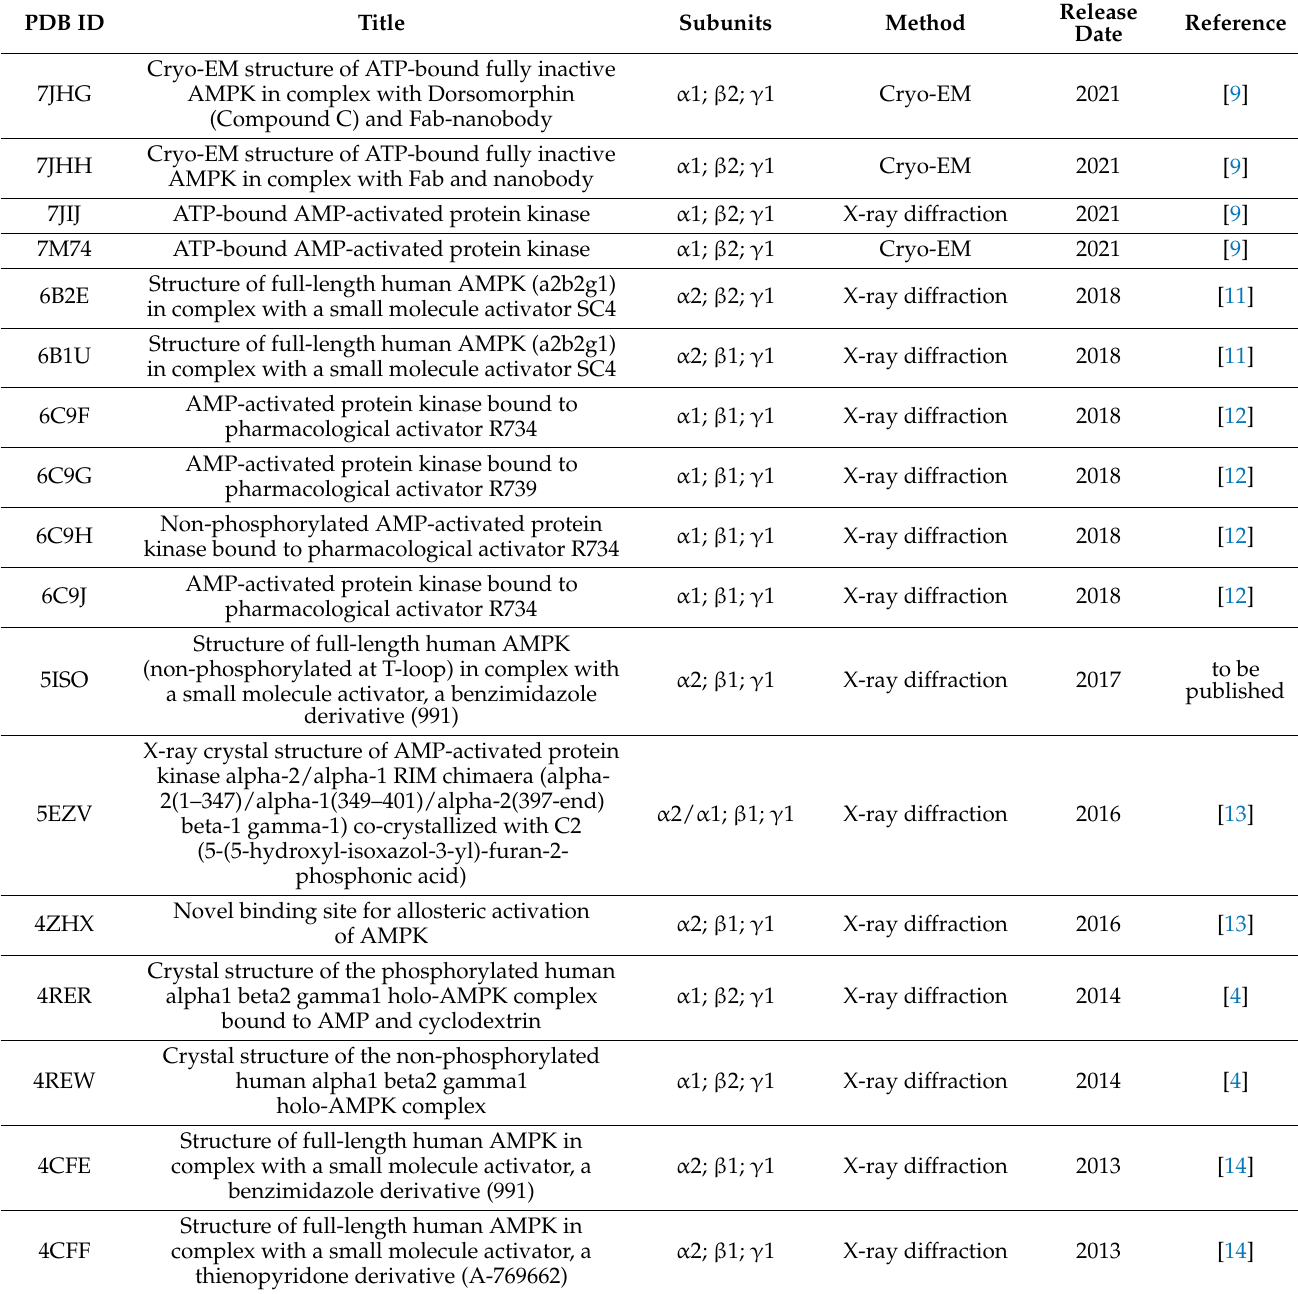
Table 2. Experimentally determined 3D structures of human AMPK, including the three α , β , and γ subunits, are available (May 2022) from the RCSB Protein Data Bank (https://www.rcsb.org/— accessed on 28 June 2022